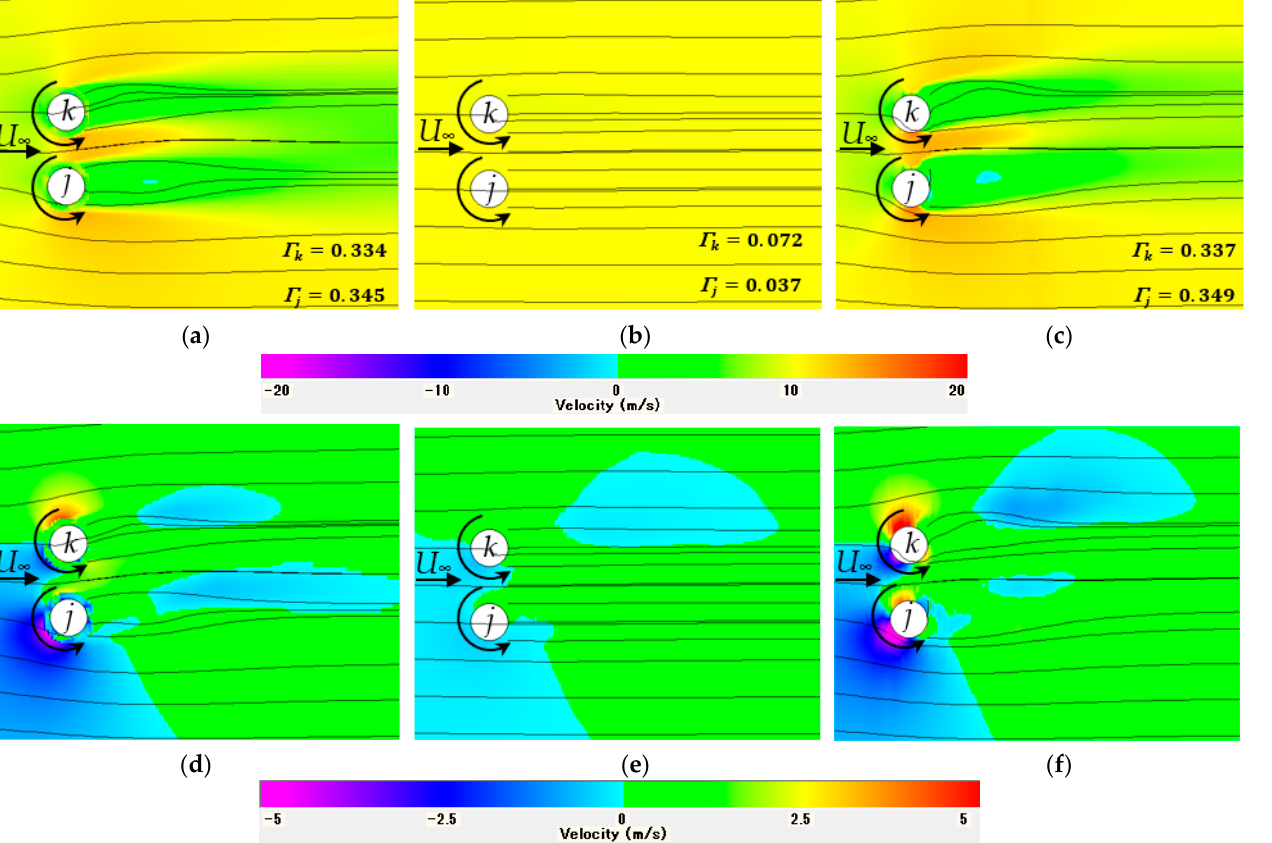
Figure 7. Three-dimensional chart showing the distribution of the value of 1 − error in the model calculation of two rotors in the CO-like layout with a wide searching range from 0.1  (cid:2903)(cid:2893) to 1.1  (cid:2903)(cid:2893) .